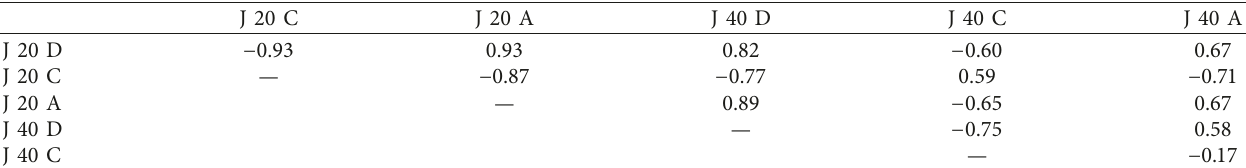
Table 6: Coefficients from Spearman’s rank correlation tests comparing dispersion, closure, and area for 20 and 40dB Z regions in Jeanne. All values are statistically significant at the 0.01 level.